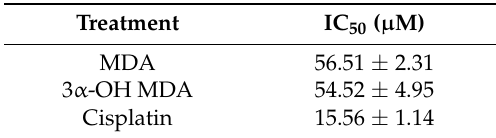
Table 1. Cytotoxic effect of MDA and 3 α -OH MDA in prostate cancer cells (PC-3) at 48 h. The inhibitory concentration 50% (IC 50 ) values represent the average of three independent assays. The data are shown as the means ± standard deviation (SD).